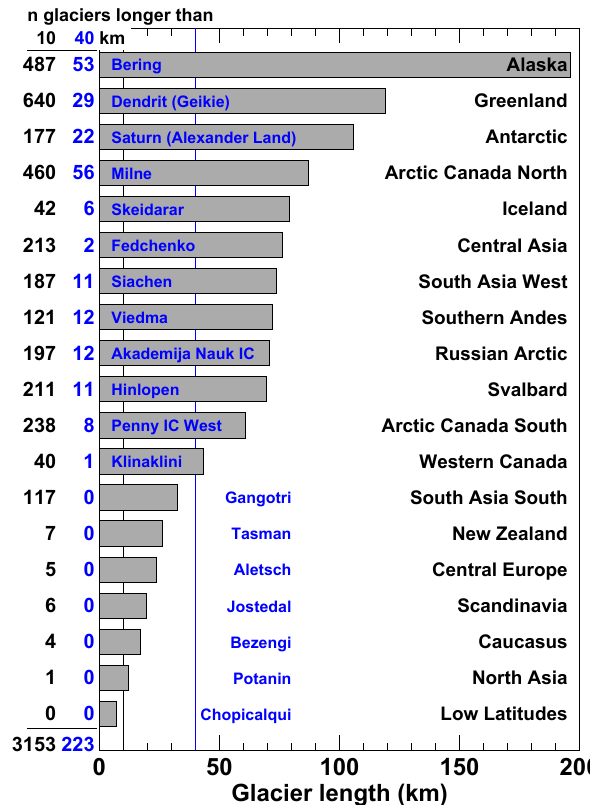
Figure 9. Longest glaciers in all regions of the Randolph Glacier Inventory. The glacier name is given in blue (IC: ice cap). The num- ber n of glaciers longer than 10 and 40km for each region is indi- cated. Note that the length of three glaciers (Milne, Skeidarar and the Akademija Nauk Ice Cap) was measured manually because the automated approach provided incorrect length due to DEM